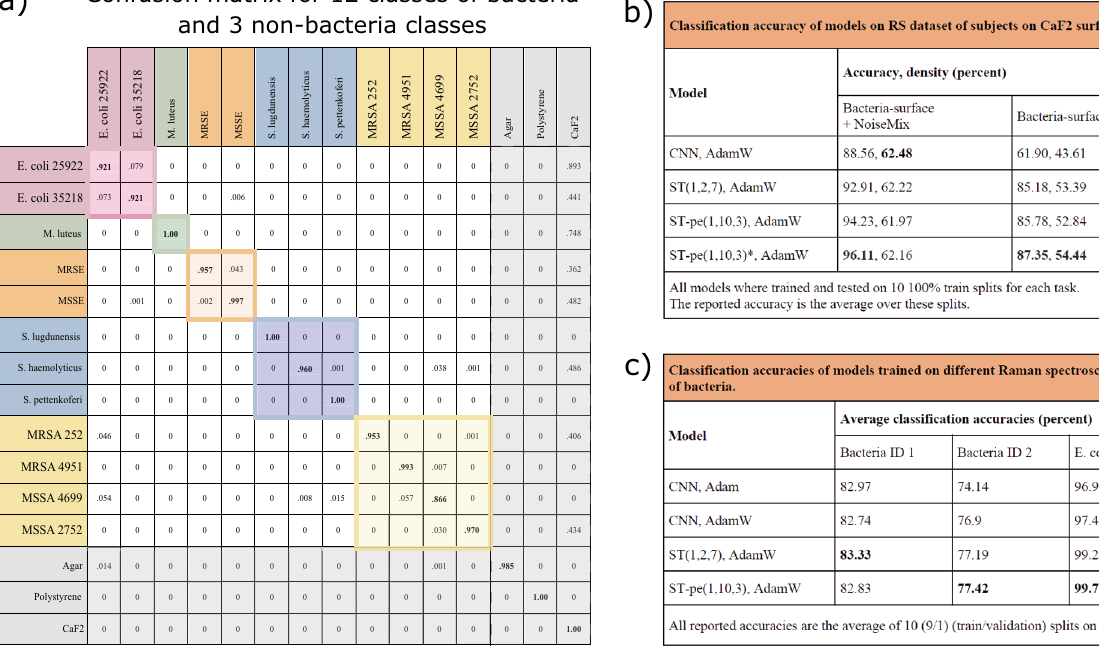
Figure 2. Performance overview of bacteria identification with the ST model and NoiseMix algorithm. ( a ) Shows the confusion matrix obtained for the classification task including 12 bacterial- and 3 non-bacterial classes (agar, polysterene, and CaF 2 ). The CaF 2 -classification column (to the right) contain non-zero elements as the sample surfaces were in some cases only partly covered by bacteria. For this reason, the non-bacterial classes are greyed out as they are not included in the bacterial identification accuracy. ( b ) Shows a comparison in performance between four different ML models trained both with and without applying NoiseMix . The results displayed in the confusion matrix are obtained using the ST-pe(1,10,3)* model trained using a batch size of 300 and the AdamW optimizer. The other three models are also trained using the AdamW optizimer but with a smaller batch size of 100. The model accuracies (and densities) represent averages over 10 training splits. In ( c ) we show the results of a benchmark test between the CNN- and the ST models when applied to three different classification tasks. The three datasets are described in the Supplementary Material. In this case the reported accuracies represent the average of 10 runs using a training/validation split of 90 % /10 %